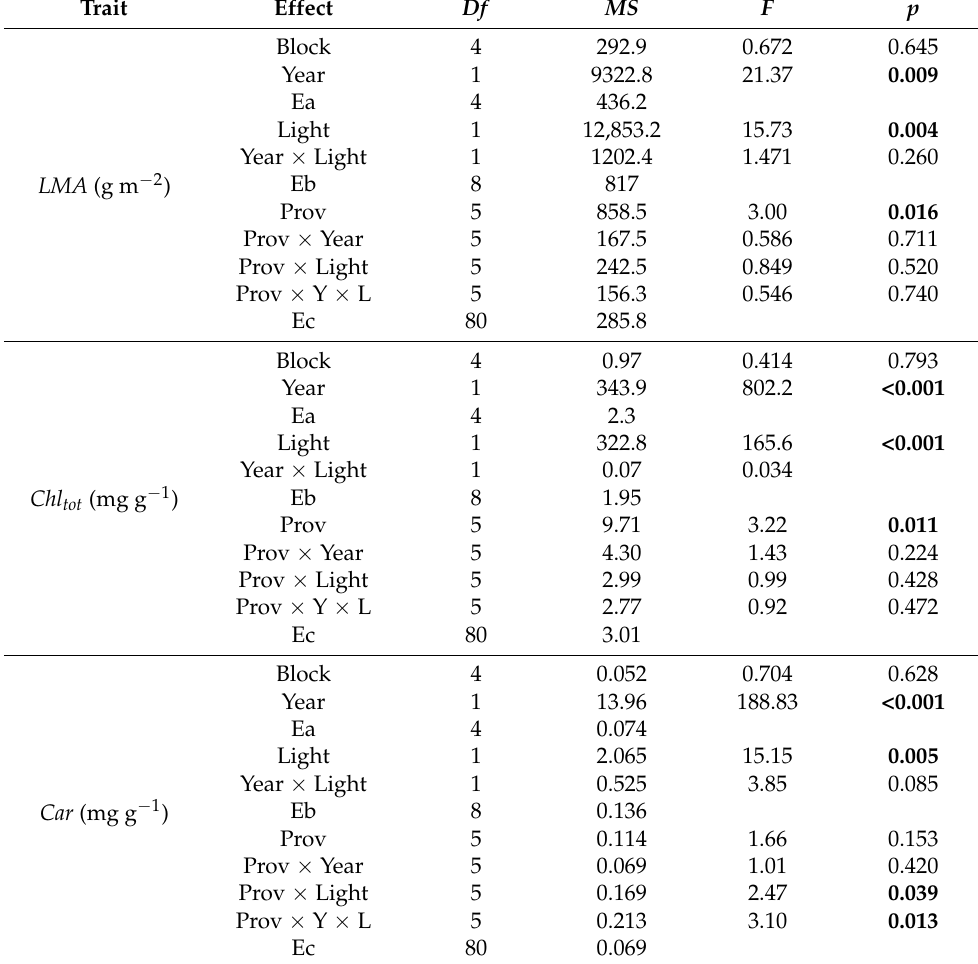
Table 4. The split-split-plot analysis of variance for the effects of blocks, date of sampling (year 2019, 2020), irradiance level (40% or 100% of full solar irradiance), and of provenance on leaf mass-to-area ratio and chlorophyll and carotenoid concentrations in needles of Abies alba seedlings. LMA —leaf mass-to-area ratio; Chl tot — total chlorophyll concentration; Car —carotenoid concentration. The values of probability in bold indicate significant differences between means ( p < 0.05).